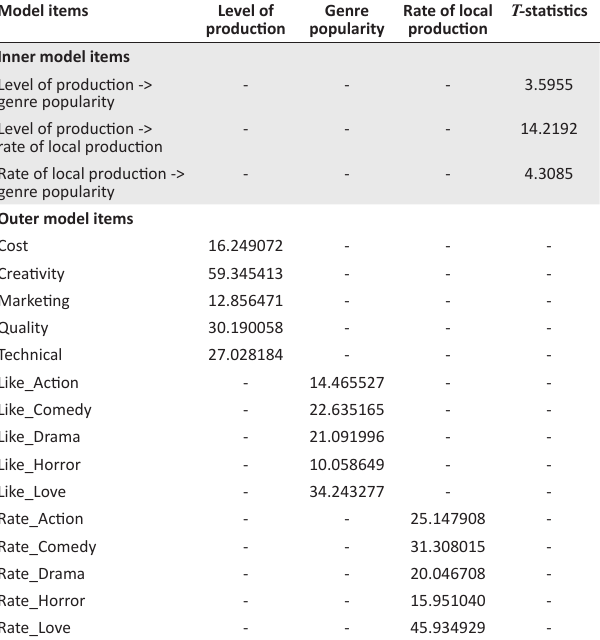
TABLE 4: T -statistics of path coefficients and outer loadings. Model items